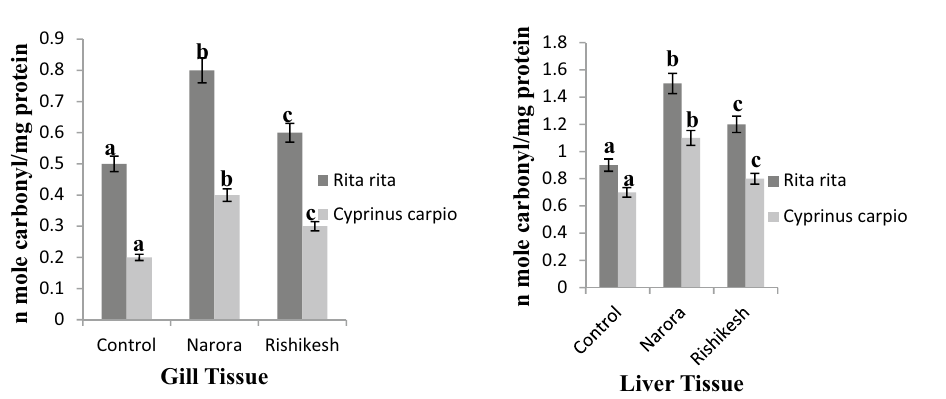
Figure 5. Protein carbonyl content in gill and liver tissues of Rita rita and Cyprinus carpio from Narora and Rishikesh. The values are expressed as mean ± SE (n = 10). Values are expressed as nanomoles of carbonyl/mg of protein. The significance levels observed is P ≤ 0.05 when compared with the control